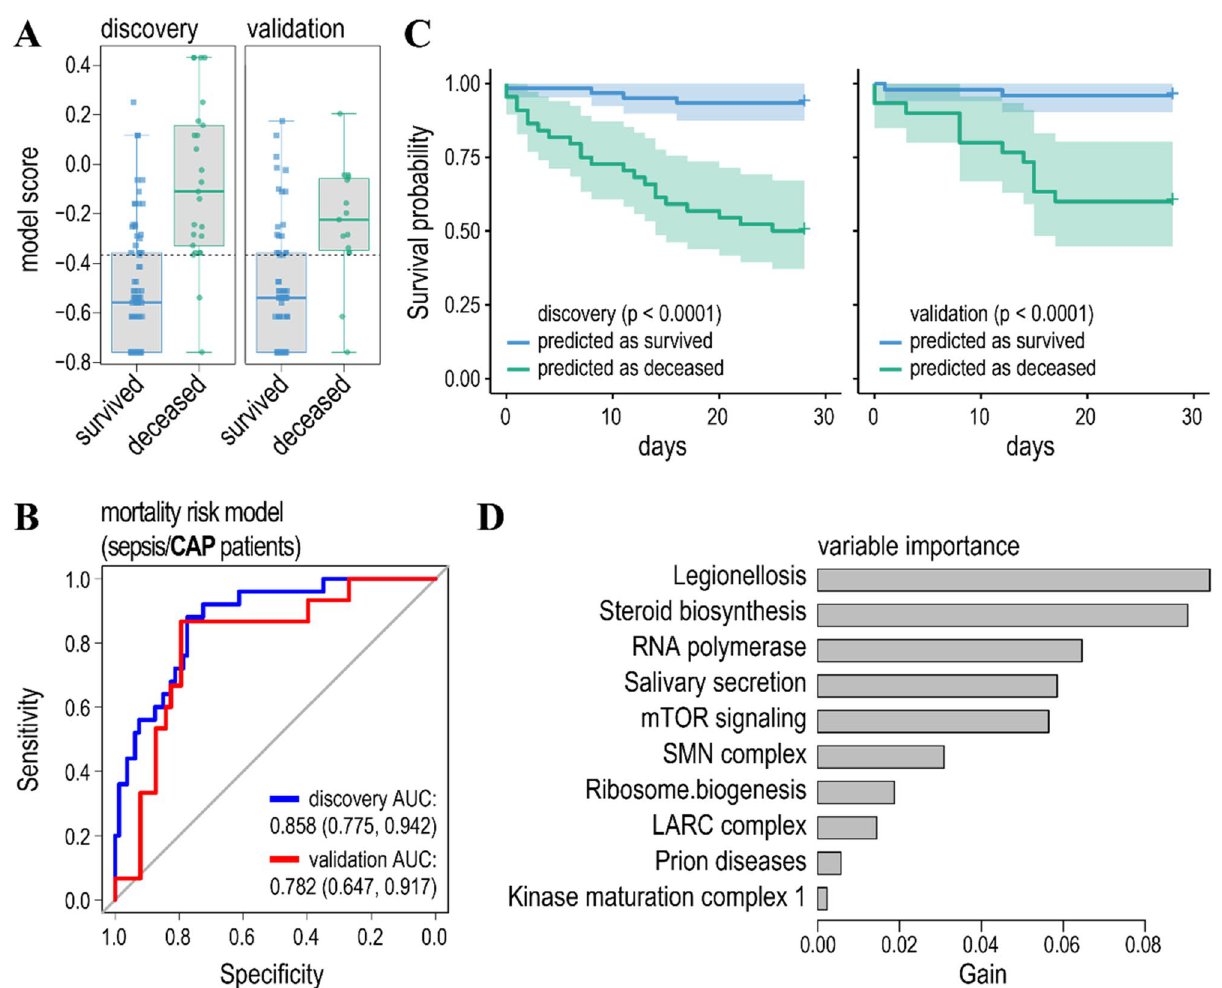
Figure 4. The model predicting mortality/survival of sepsis/CAP patients. ( A ) Boxplots of the model scores predicting mortality/survivorship in the discovery (left) and validation (right) cohorts. ( B ) ROC curves for the model predicting mortality in sepsis/CAP patients in the discovery (blue line) and validation (red line) cohorts. Cohorts were partitioned as in the previous study 8 . ( C ) Survival probability for the patients predicted to have low (blue line) and high (green line) risk of mortality for the discovery (left panel) and validation (right panel) cohorts. ( D ) Relative contribution of gene ensemble noise features to the